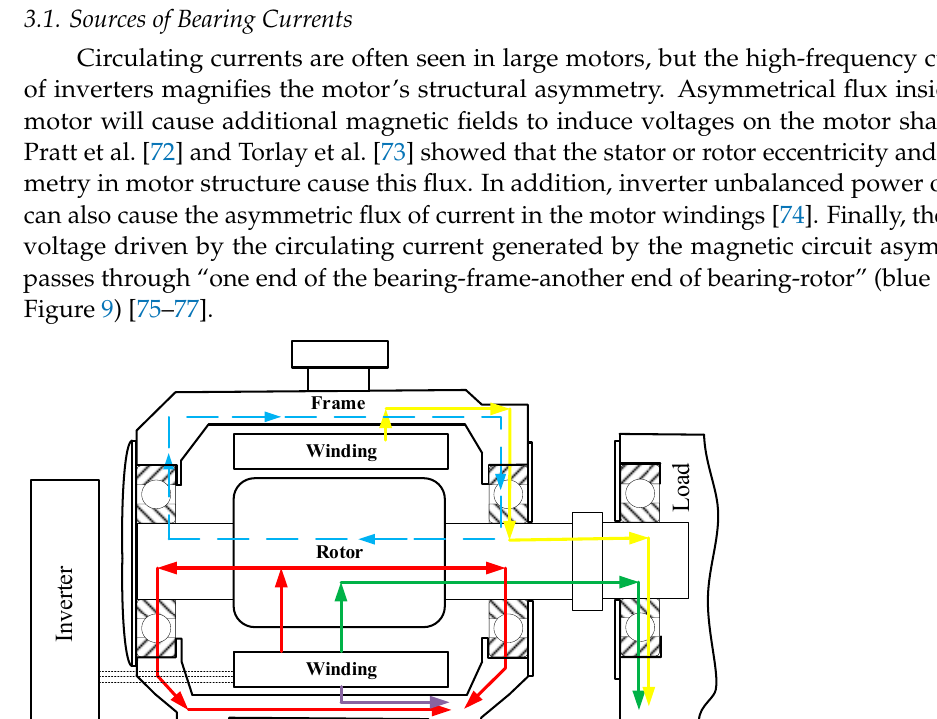
C b Figure 11. Capacitance coupling in an induction motor. 3.2. Motor Structure Parameters The structural characteristics of the motor will affect the equivalent capacitance in- side the motor, which will affect the shaft voltage and bearing current. Schuster et al. [84] investigated the bearing current of two types of permanent magnet synchronous ma- chines (PMSM, 90 kW) with different stator slots and geometric shapes, and discovered that the voltage division ratio (BVR) of motor bearings with the longer axial core length is higher and keeping the stator windings away from the rotor surface can reduce coupling capacitance and the peak value of bearing current. Peng et al. [85] investigated the impact combinations of magnetic poles and stator slots on the shaft voltage of magnet machines and discovered that stator slots can reduce the induced shaft voltage. It is worth noting that the 8-pole 12-slot combination has a high induction shaft voltage. Han et al. [86] used a coupled field-circuit electromagnetic finite element analysis (FEA) to study the effect of winding distribution on bearing voltage and bearing current. Muetze et al. [87] found that the stator slot and cooling duct frame have a large effect on the common-mode flux, which will cause circulating bearing currents. By studying the